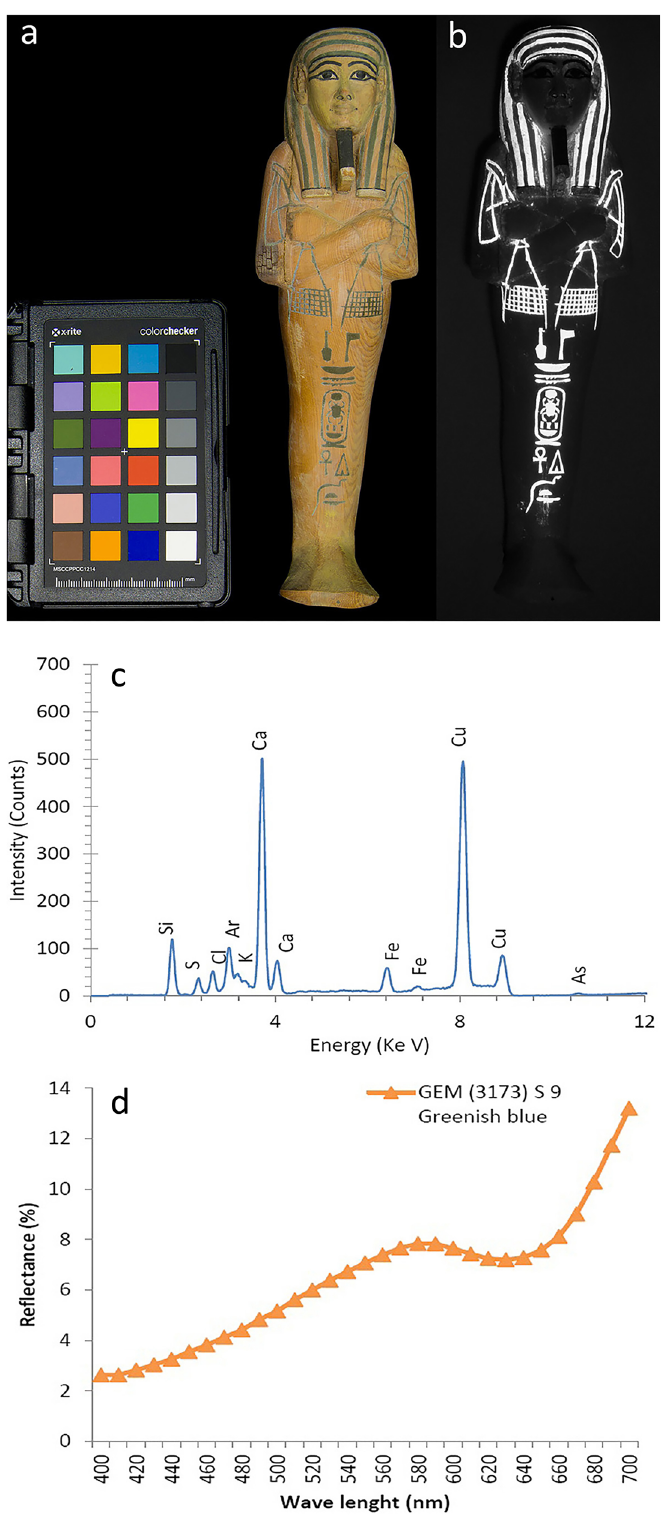
Figure 3: Characterization of the greenish blue painted layer ( Object GEM 3173, Spot 9 ) : ( a ) visible image; ( a ) VIL image; ( c ) XRF spectrum; and ( d ) visible re fl ectance